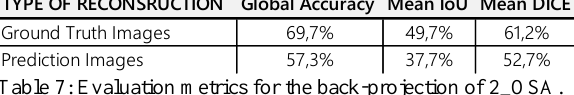
Table 7: Evaluation metrics for the back-projection of 2_OSA.